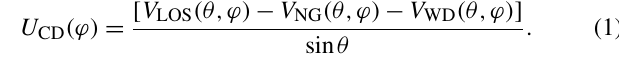
Figure 1. (a) Schematic of the ATR-42 aircraft and KuROS instru- ment with a definition of viewing angles, azimuth ϕ and incidence angle θ . (b) A comparison with the SKIM viewing geometry. The unit vector e ϕ is the projection on the horizontal of the line-of- sight direction vector. The variation of surface backscatter across the footprint and as a function of azimuth ϕ , which causes the effec- tive mispointing δϕ , is represented as gray shading. In the KuROS data, each measurement is integrated in azimuth across the antenna lobe. In the case of SKIM, the use of unfocused SAR processing allows for the separation of echoes in the azimuth direction with a resolution of dDop (cid:39)